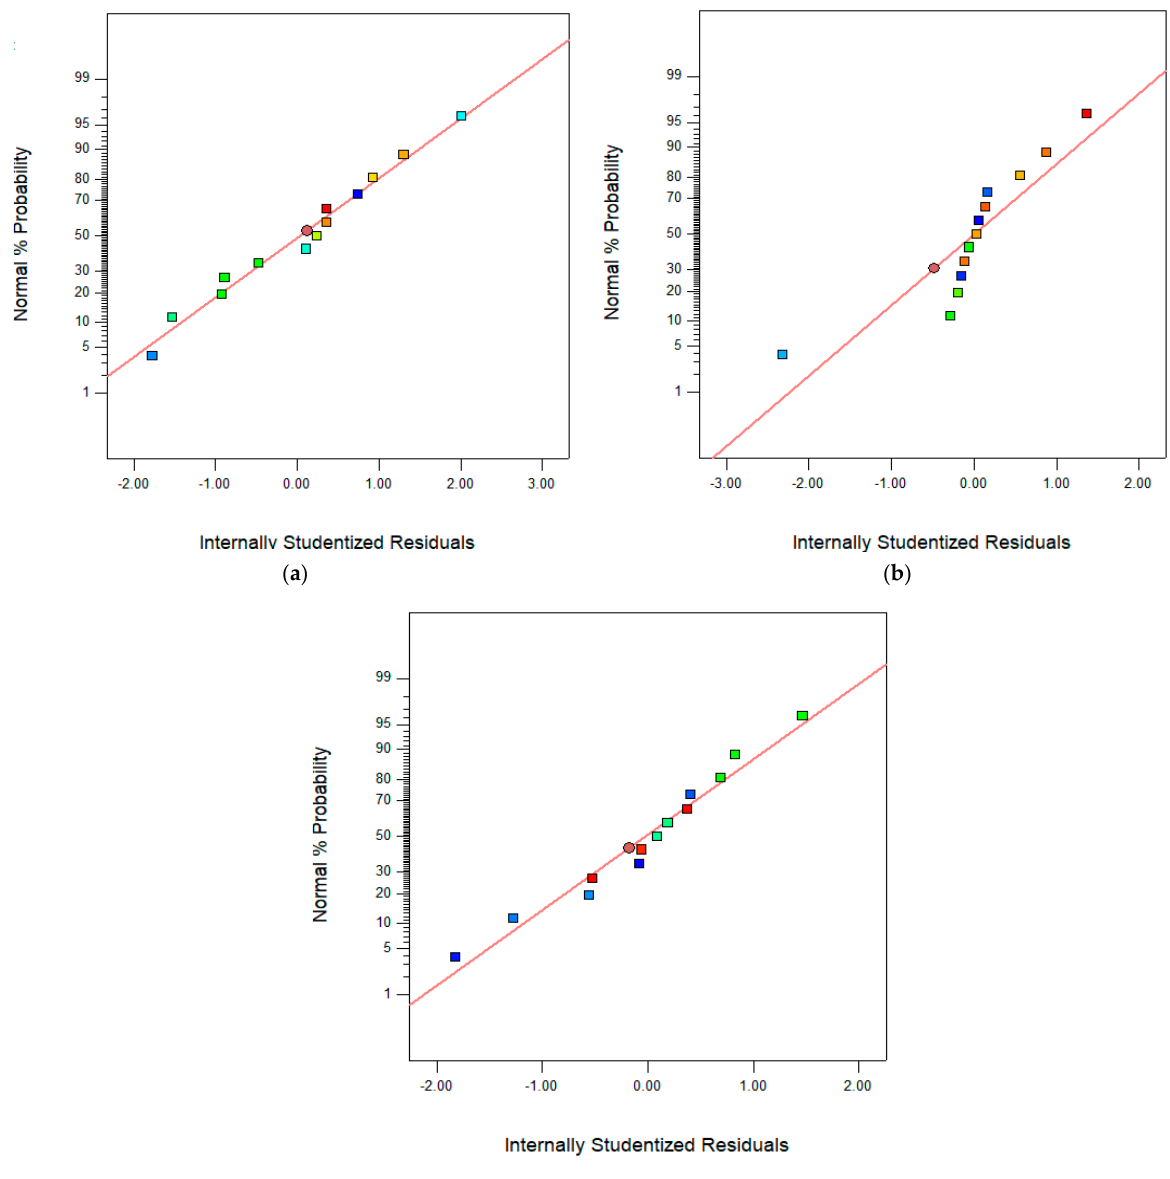
Figure 5. Normal plot against internally studentized residuals for residual compressive strength models for ( a ) Control Temperature (27 °C), ( b ) 200 °C, and ( c ) 400 °C. The 3D plots of residual compressive strength models at 27 °C, 200 °C, and 400 °C are presented in Figure 6a–c, respectively. The residual compressive strength decreased with an increase in elevated temperature. At all of the temperatures, the residual compressive strength decreases with incrementally replacing fine aggregate with CR. At elevated tem- peratures, the decrease in residual compressive strength with increased substitution of